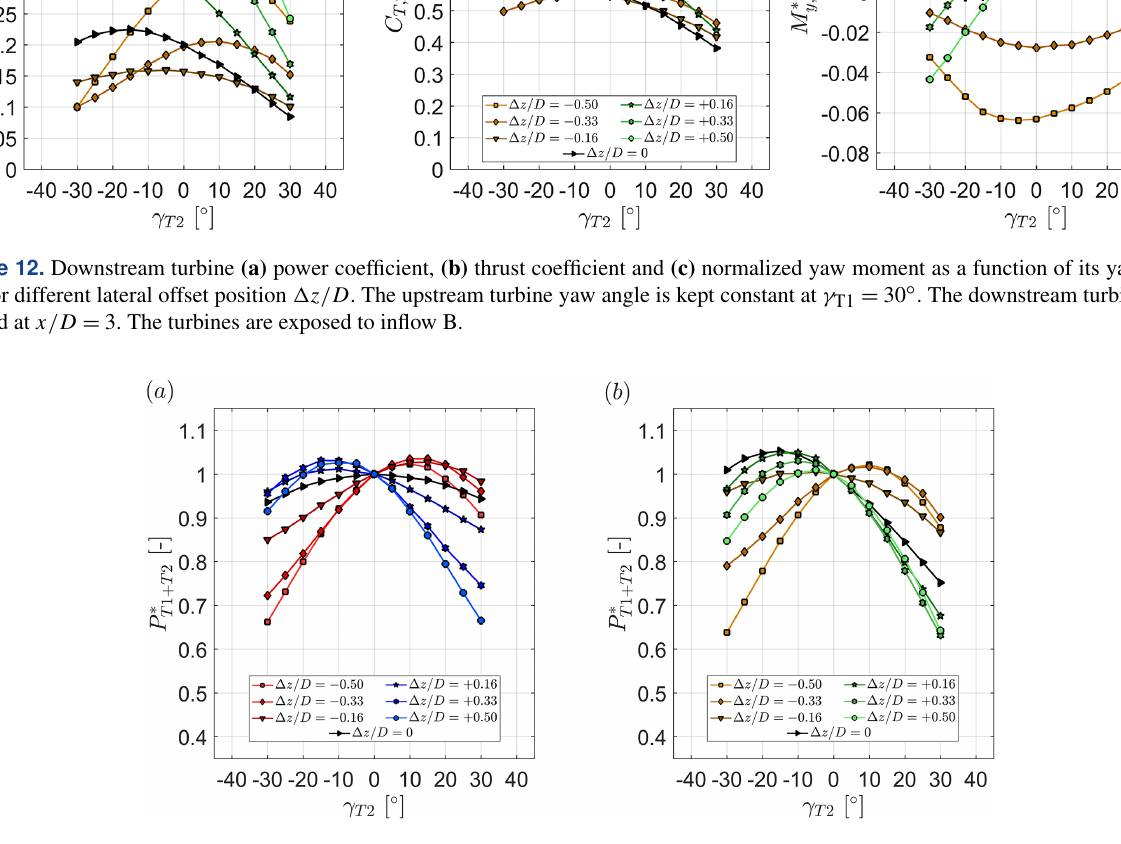
of two turbines as a function of the downstream turbine yaw angle γ T2 for different lateral Figure 13. Combined relative power P ∗ T1 + T2 offset positions (cid:49)z/D . The upstream turbine yaw angle is kept constant at (a) γ T1 = 0 ◦ and (b) γ T1 = 30 ◦ . The downstream turbine T2 is located at x/D = 3. The turbines are exposed to inflow